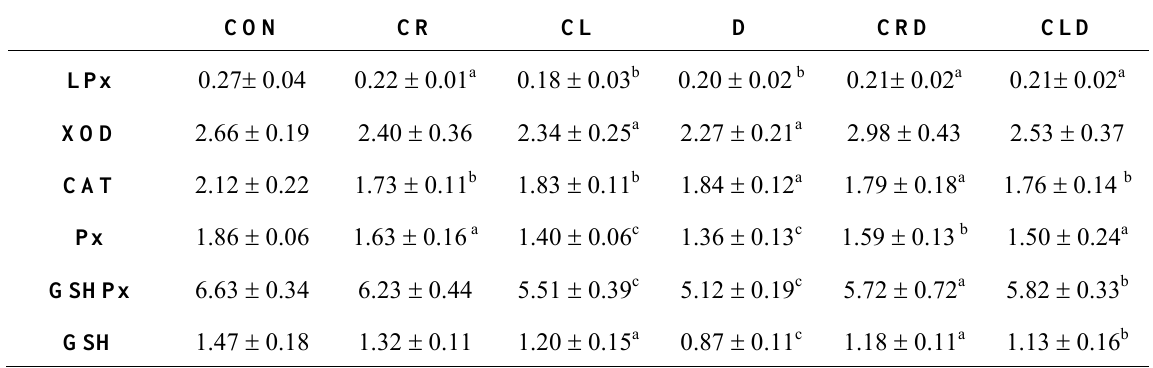
Table 3 . Investigated Biochemical Parameters in Blood Hemolysate